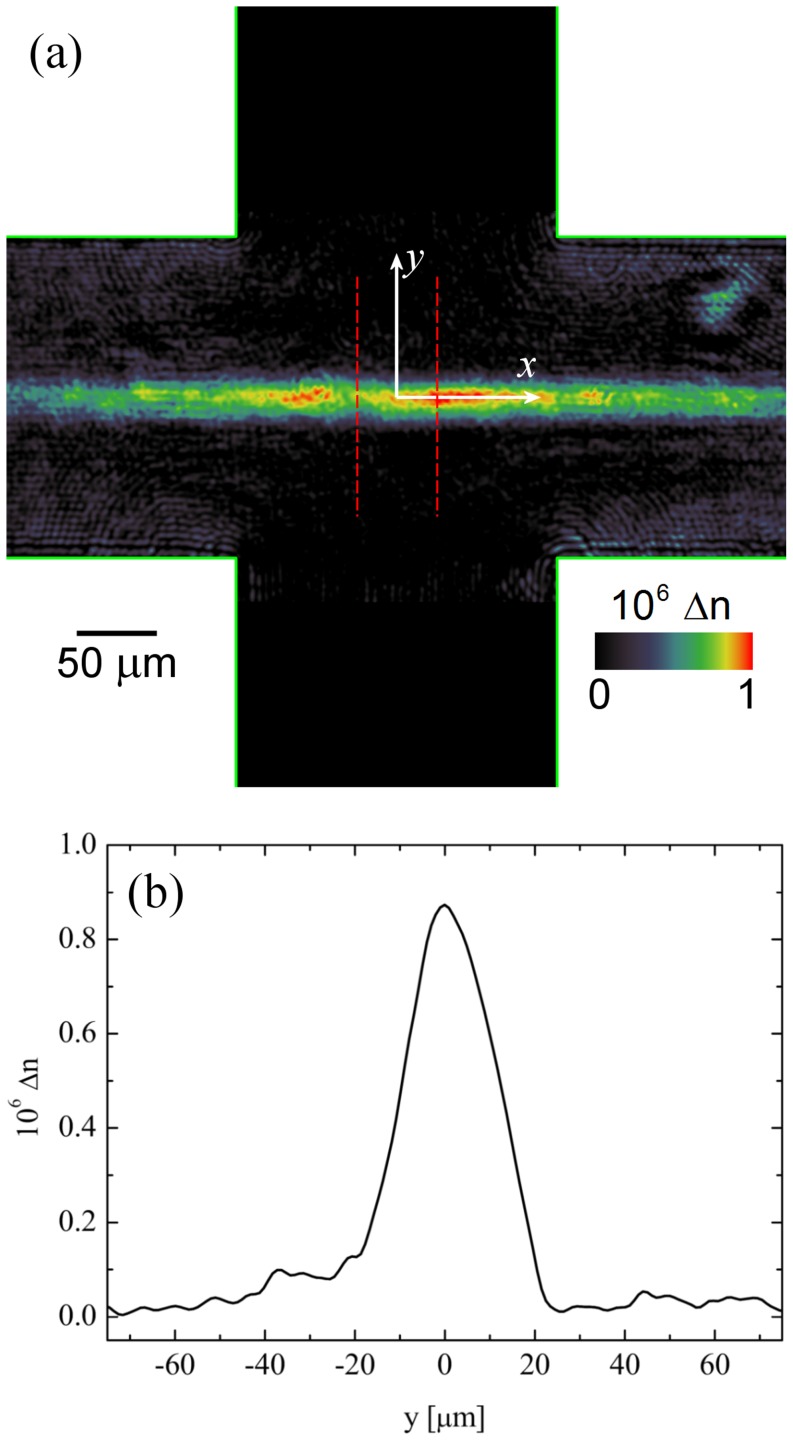
Birefringence in the cross-slots for a porcine synovial fluid (PSF) sample diluted by a factor of 20× with phosphate-buffered saline (PBS).(a) An image of a birefringent strand at a nominal strain rate of   =  1346 s−1. Flow enters through the vertical channels and exits through the horizontal channels. The image also indicates the coordinate system, with origin at the stagnation point. (b) A line profile across the birefringent strand where pixel values have been averaged between the dashed lines centred on x = 0 as shown in (a). The peak intensity at y = 0 can be taken as the measurement value of Δn for this test case.